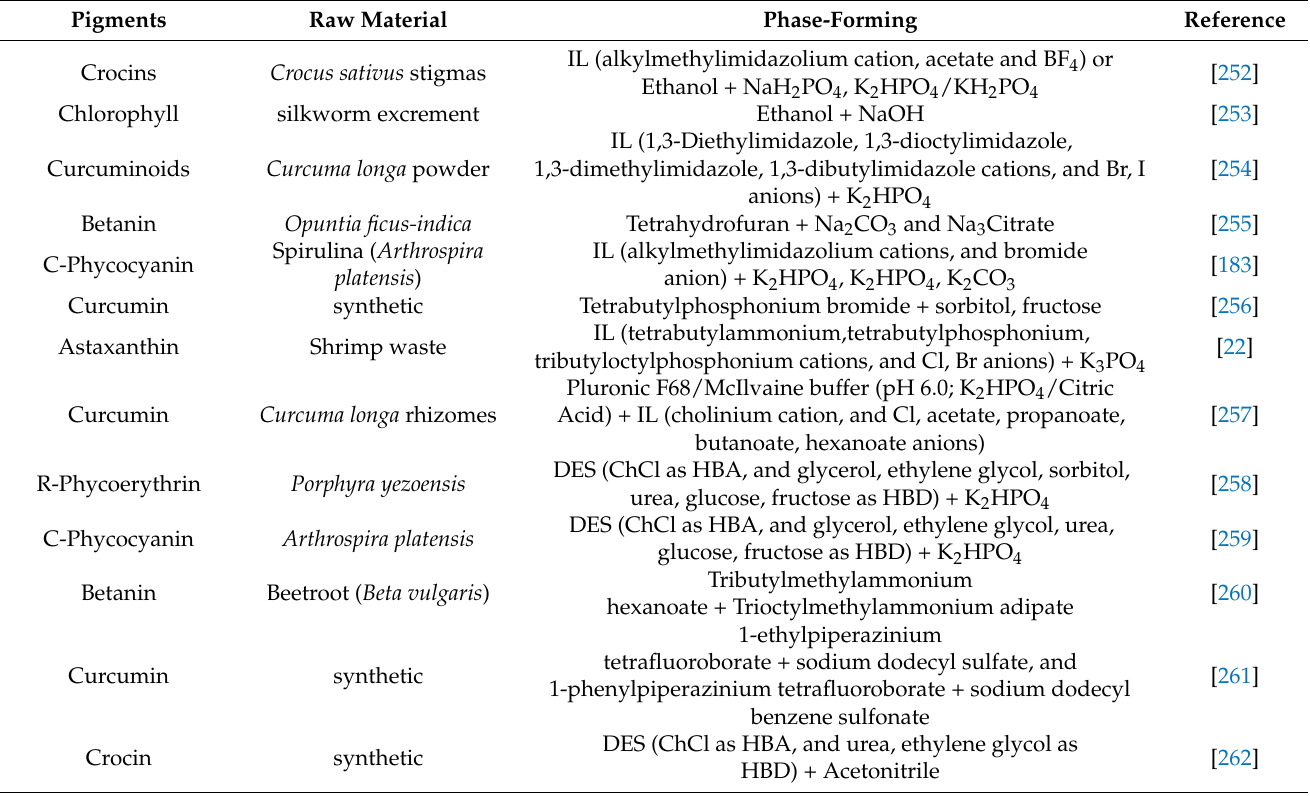
Table 3. Non-conventional ATPS in the extraction and recovery of natural pigments.